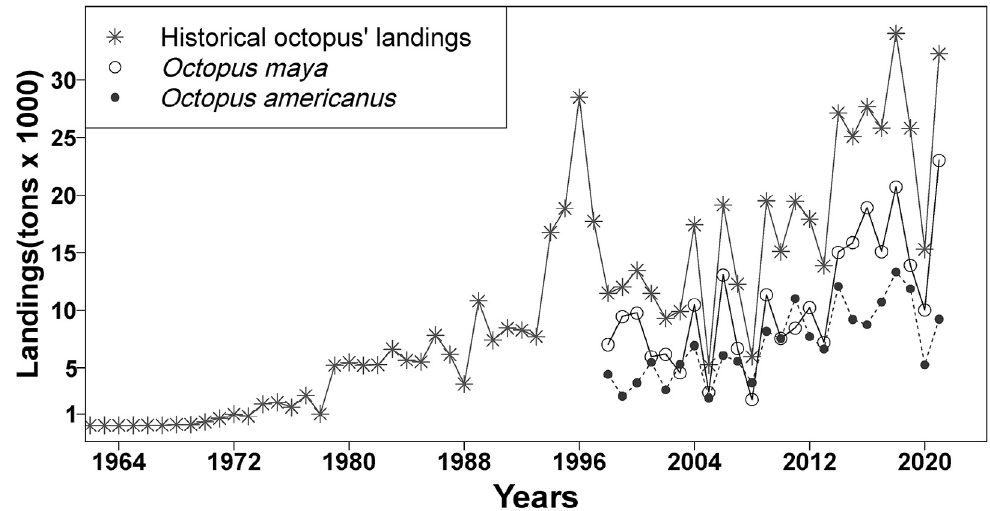
Fig. 2. – Historical official octopus landings in Yucatan from 1966 to 2021. Landings by fishery fleet from 1998 to 2021: O. maya (small-scale fleet), and O. americanus (large-scale fleet). (Source: Instituto Nacional de Pesca y Acuacultura, Yucalpeten, México.